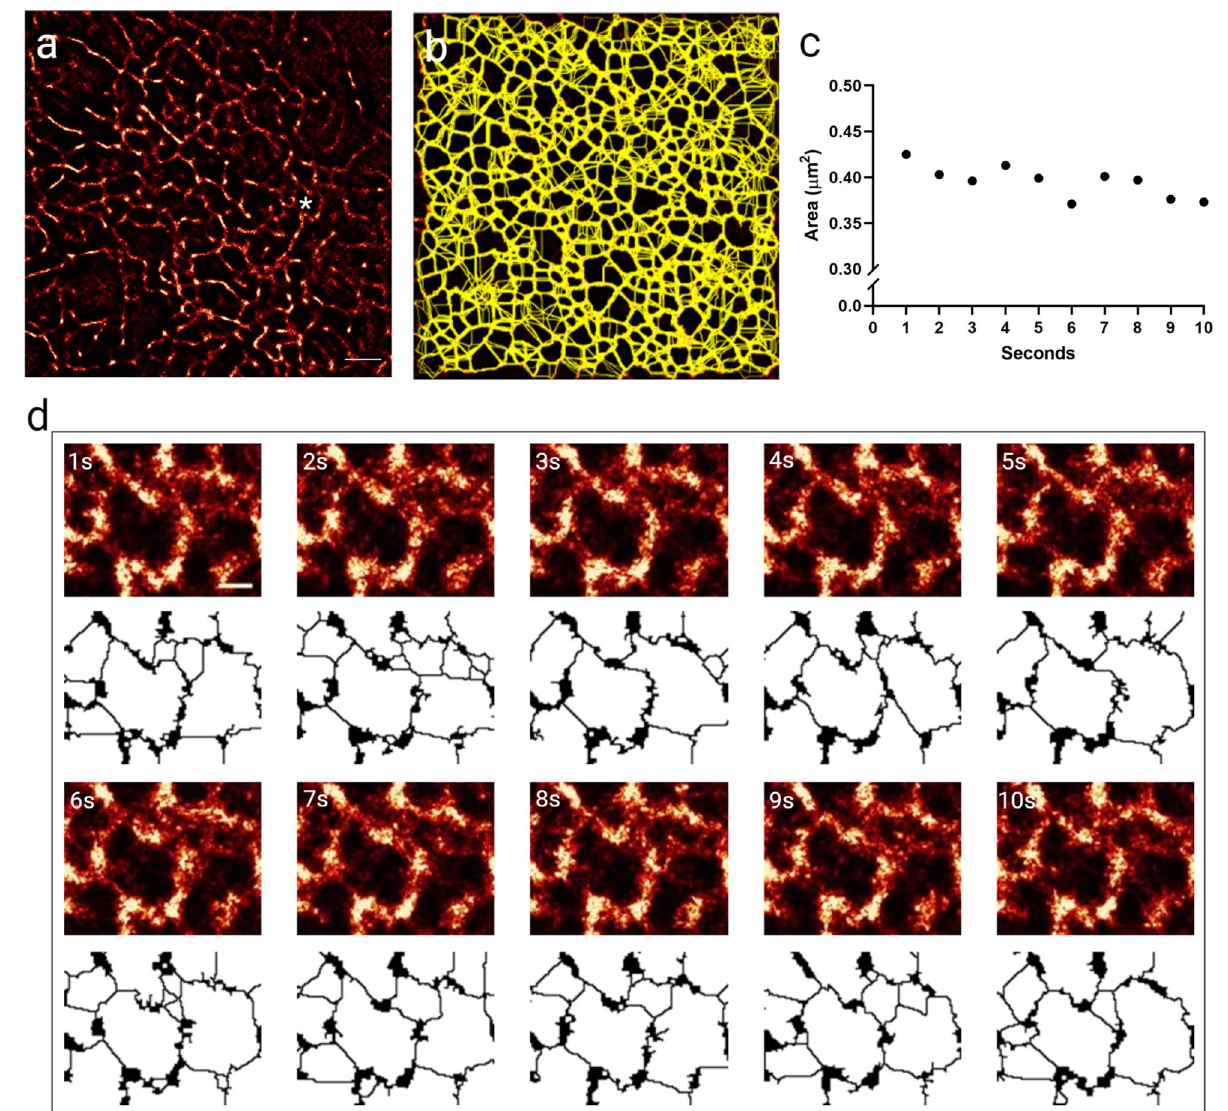
Supplementary Video 1). ( c ) Plot of the area of the corral marked with * in a) over time. ( d ) Frame by frame images of the corral marked in ( a ) and plotted in ( c ), showing the raw and processed